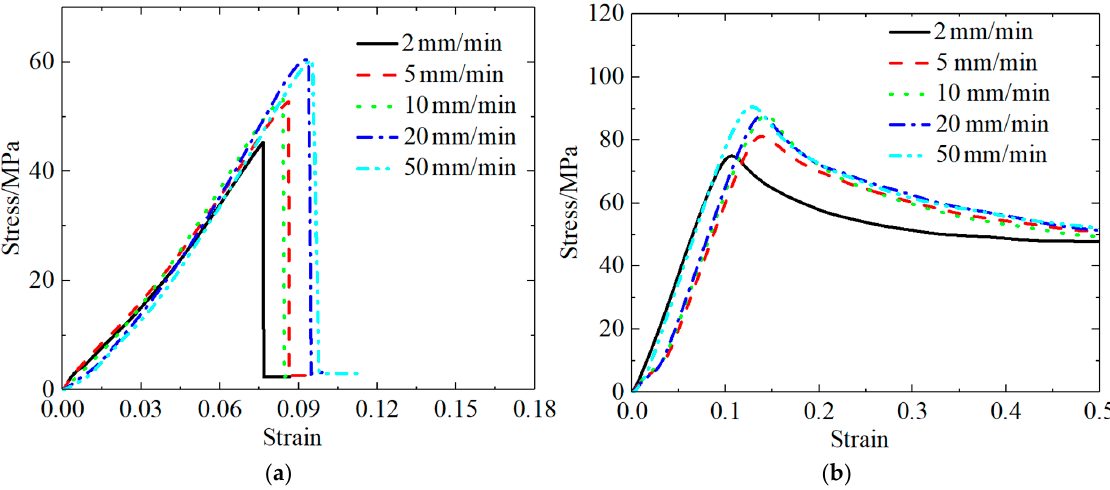
Figure 4. Quasi ‐ static stress ‐ strain curve of PLA ‐ Cu material. ( a ) Tensile stress ‐ strain curve; ( b ) compression stress ‐ strain Figure 4. Quasi-static stress–strain curve of PLA-Cu material. ( a ) Tensile stress–strain curve; ( b ) compression stress–strain curve.